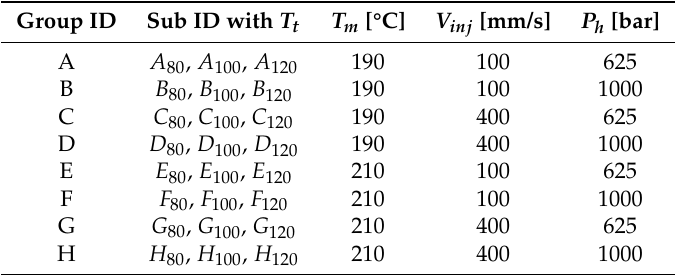
Table 3. Process parameters settings for the DOE plan.